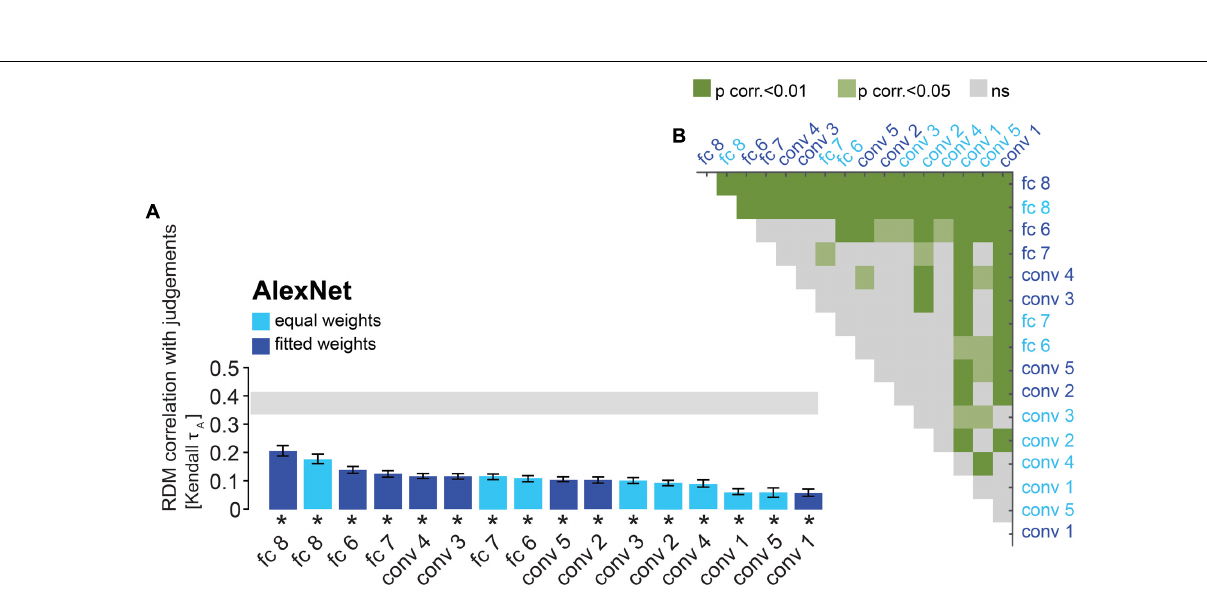
FIGURE 4 | AlexNet performance at explaining similarity judgments: reweighting improves model performance for late layers. (A) Bars show the correlation between the similarity-judgment RDMs and each AlexNet layer RDM, with and without reweighting. A significant correlation between a layer RDM and the similarity-judgment RDMs is indicated by an asterisk (one-sided Wilcoxon signed-rank test, p < 0.05 corrected). Error bars show the standard error of the mean based on single-subject correlations, i.e., correlations between the single-subject similarity-judgment RDMs and a DNN RDM. The gray bar represents the noise ceiling, which indicates the expected performance of the true model given the noise in the data. “conv” indicates a convolutional layer and “fc” indicates a fully-connected layer. (B) Pairwise differences between model performance of AlexNet layer RDMs, with and without reweighting. Green color indicates significant pairwise differences (dark green p < 0.01, light green p < 0.05, FDR corrected across all